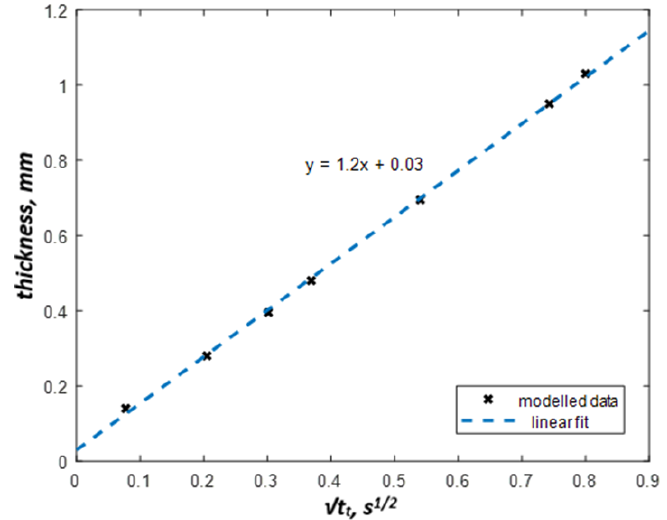
Figure 6. Square root of threshold time vs. coating thickness (modeling).